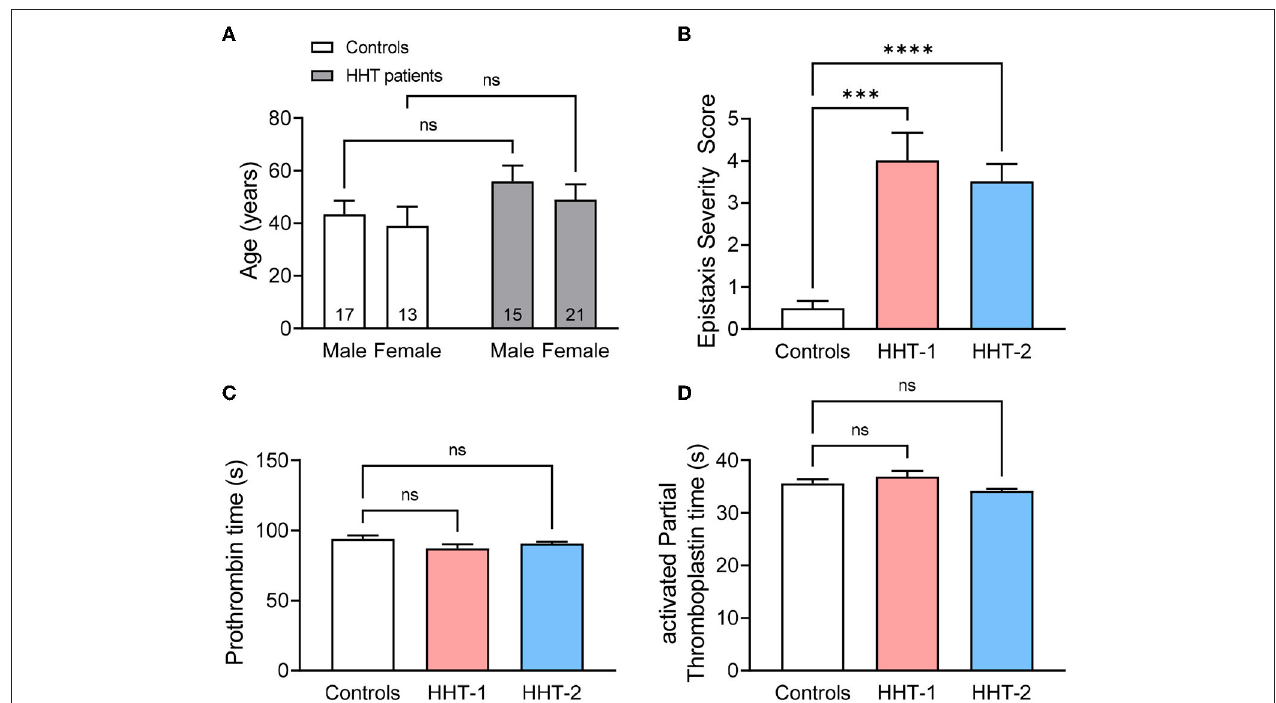
FIGURE 1 | (A) Mean age of HHT patients ( n = 15 males and 21 females) and its relatives unaffected by the disease that are the controls ( n = 17 males and 13 females) of the study, disaggregated by gender. (B) Epistaxis Severity Score of controls ( n = 30), HHT-1 ( n = 5) and HHT-2 ( n = 31) patients. (C,D) Prothrombin time (C) and activated Partial Thromboplastin time (D) of controls, HHT-1 and HHT-2 patients. Results were considered statistically significant if p < 0.05 (ns: non-significant; *: p < 0.05; **: p < 0.01; ***: p < 0.001; ****: p <